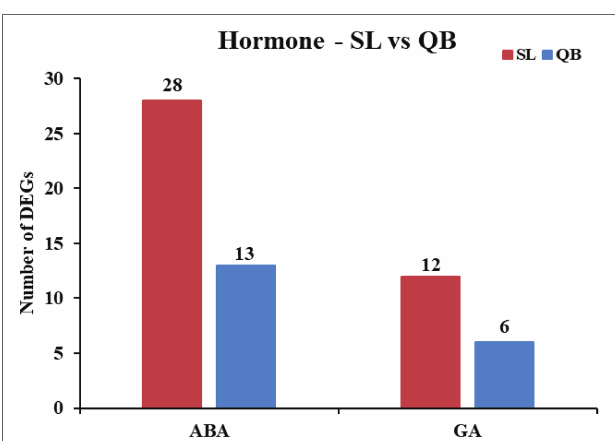
FIGURE 10 | Statistics of DEGs related to negatively regulating abscisic acid (ABA) and positively regulating gibberellin (GA) in Swan Lake (SL) and Qingdao Bay